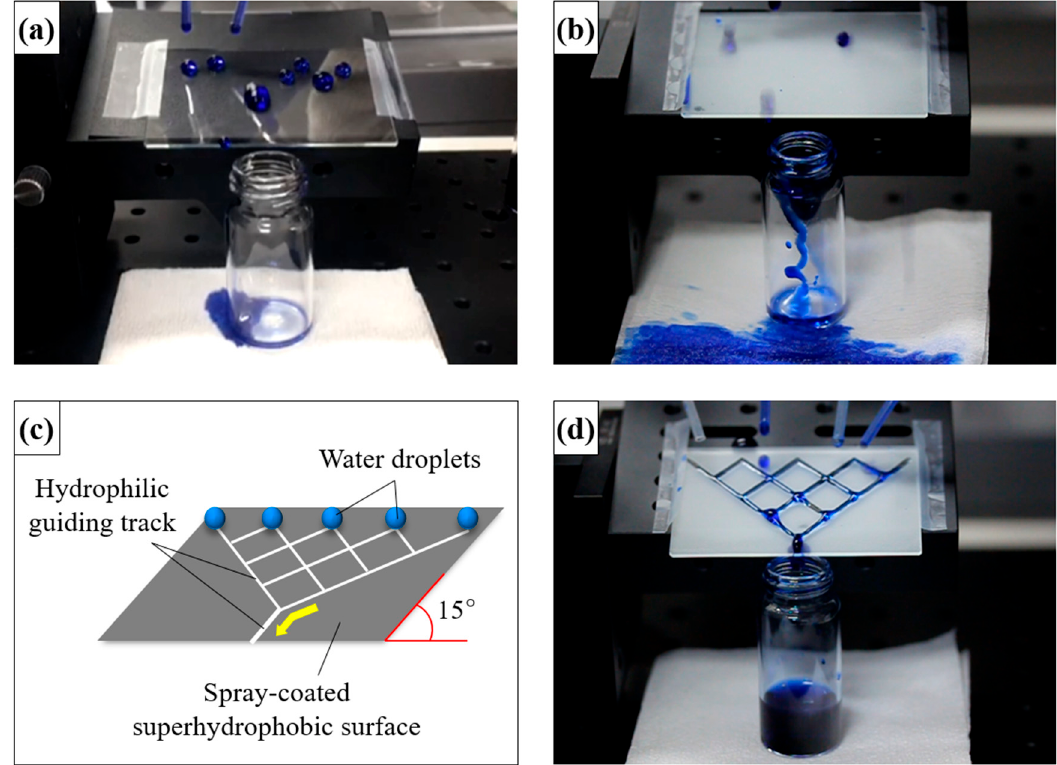
Figure 5. Transportation and collection of water droplets dyed with methylene blue on coated surfaces tilted at 15 ◦ . ( a ) Hydrophobic surface with no silica NPs; ( b ) superhydrophobic surface with NPs; ( c ) schematic of a superhydrophobic surface with hydrophilic patterns; and ( d ) patterned superhydrophobic surface.